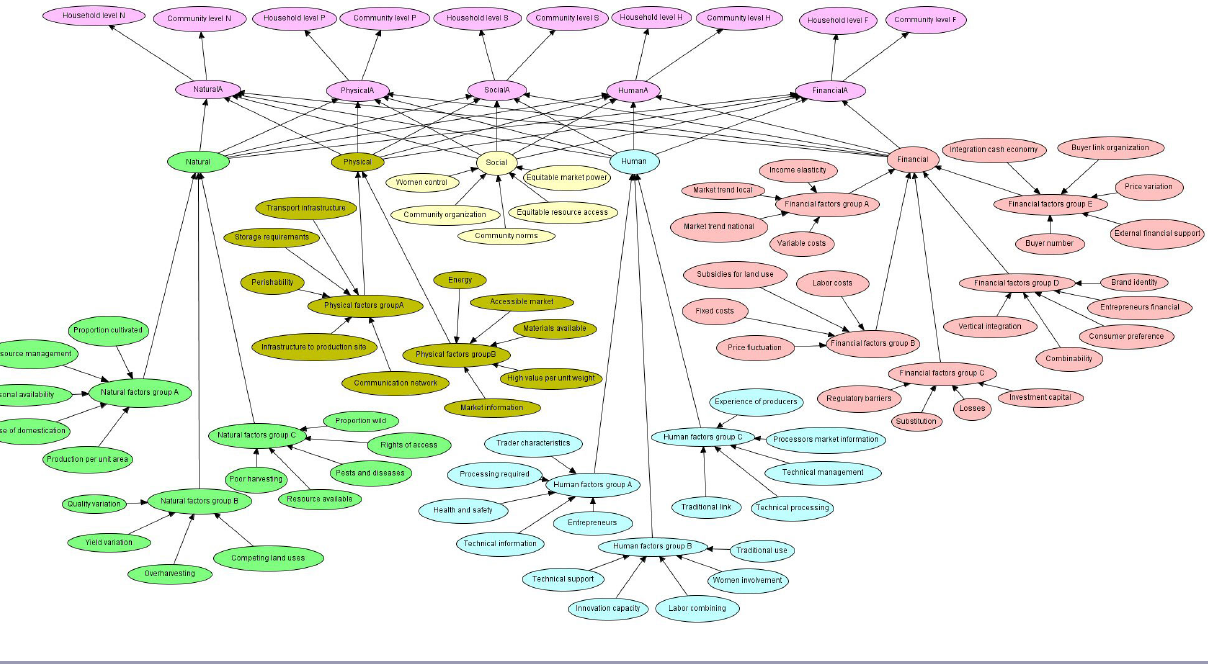
Fig. 2. Structure of Bayesian Belief Network (BBN) used to model the impact of NTFP commercialization on livelihoods. Factors are grouped in terms of the type of capital asset that they influence: natural (light green), physical (dark green), social (yellow), human (blue), and financial (red). The availability of each type of asset before commercialization influences availability after commercialization (denoted A in each case). Post-commercialization asset availabilities determine the impacts on livelihoods at both household and community levels, represented by separate nodes in each